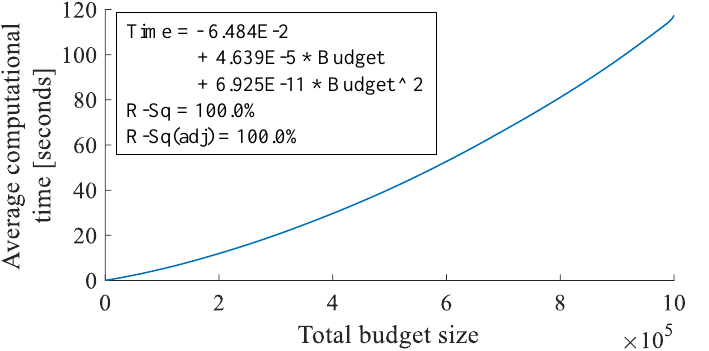
Figure 10. The average computational time required for the proposed method in Problem F4 ( 2, ··· ,2 ) as the total budget increases. A total of 20 replications are